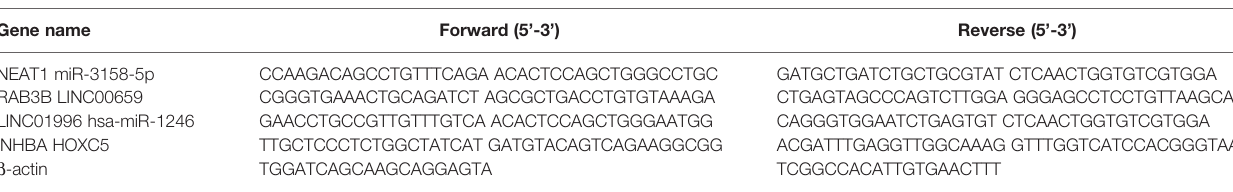
TABLE 1 | The primers for real-time